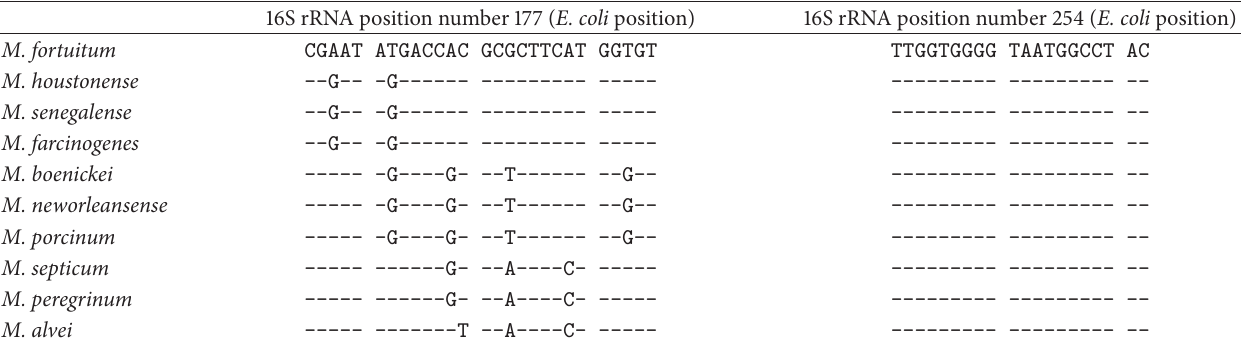
Table 2: Comparison of 16S rDNA signature sequences. The alignment comprises the two variable regions found in the 16S rRNA genes of selected members of species closely related to M. farcinogenes and M. senegalense ; “ - ” indicates identity. 16S rRNA position number 177 ( E. coli